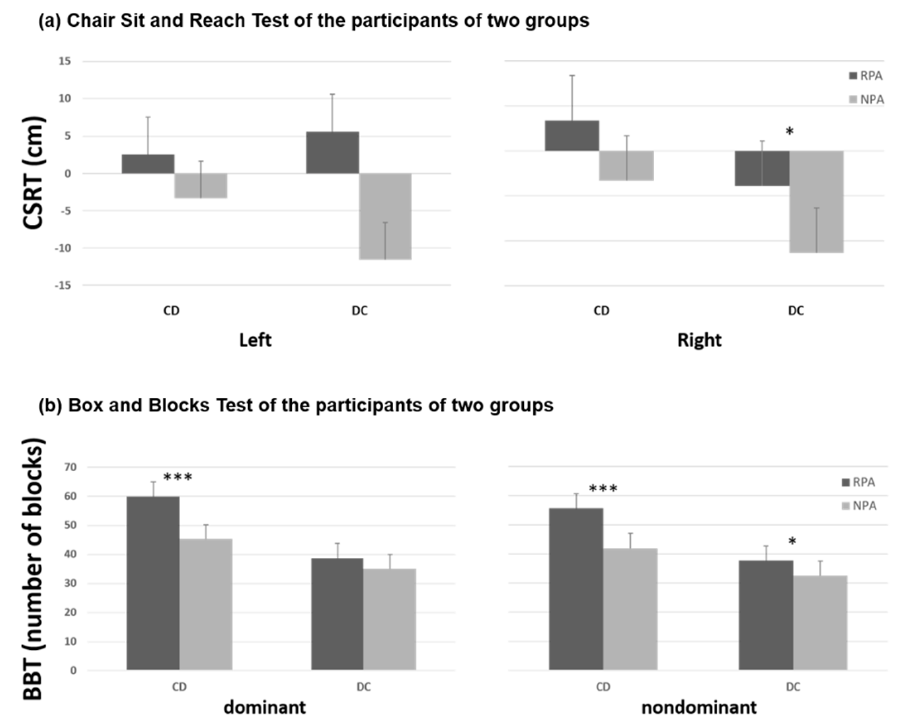
Figure 2. ( a ) Chair sit and reach test and ( b ) box and block test of the participants of two groups; * p < 0.05; *** p < 0.01.